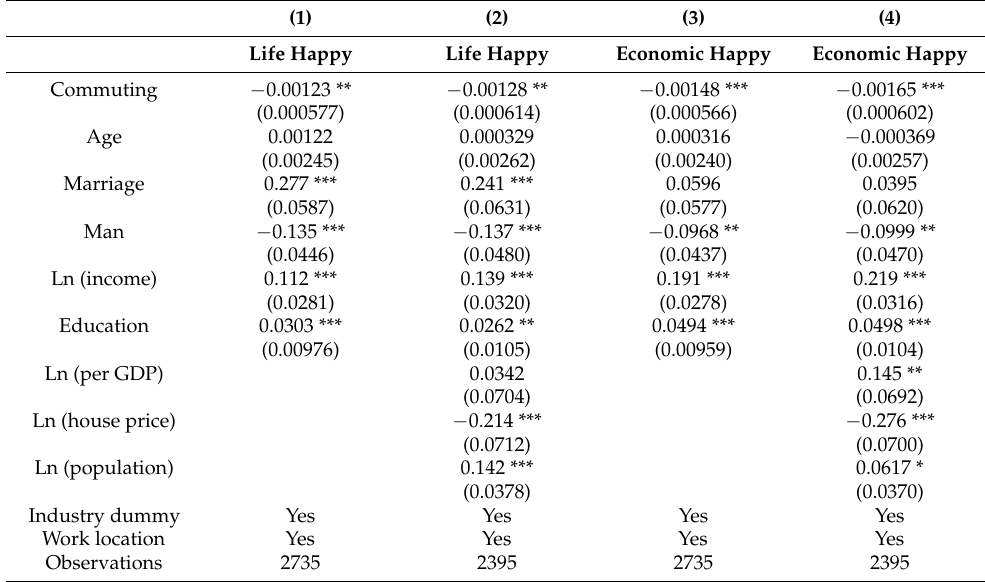
Table 1. Commuting and quality of